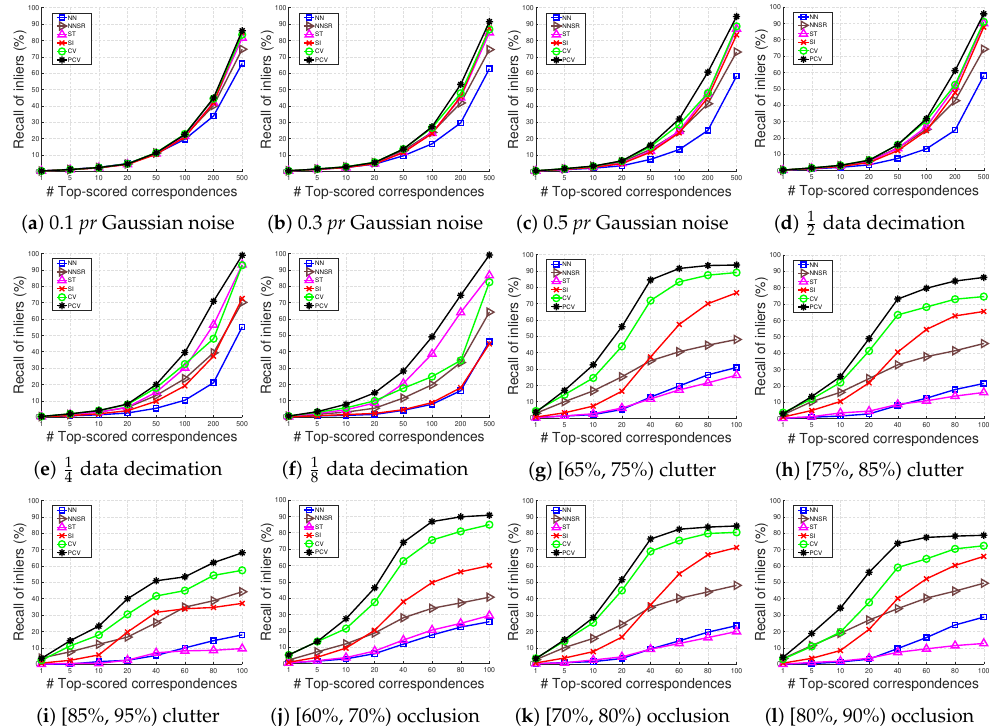
Figure 6. ROI performance of PCV and compared methods under different levels of ( a – c ) Gaussian noise, ( d – f ) data decimation, ( g – i ) clutter, and ( j – l )